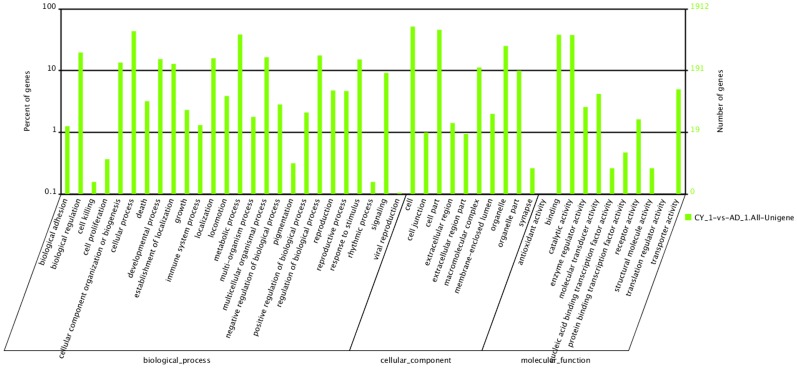
Gene Ontology (GO) categories of the differentially expressed genes (DEG) in artificial diet-fed (AD_1) vs. prey-fed (CY_1) treatments.In total, 1,912 DEGs of A. chinensis were annotated in three categories: biological processes (26 sub-categories, 4,713 sequences), cellular components (10 sub-categories, 2,853 sequences) and molecular functions (11 sub-categories, 1,725 sequences).